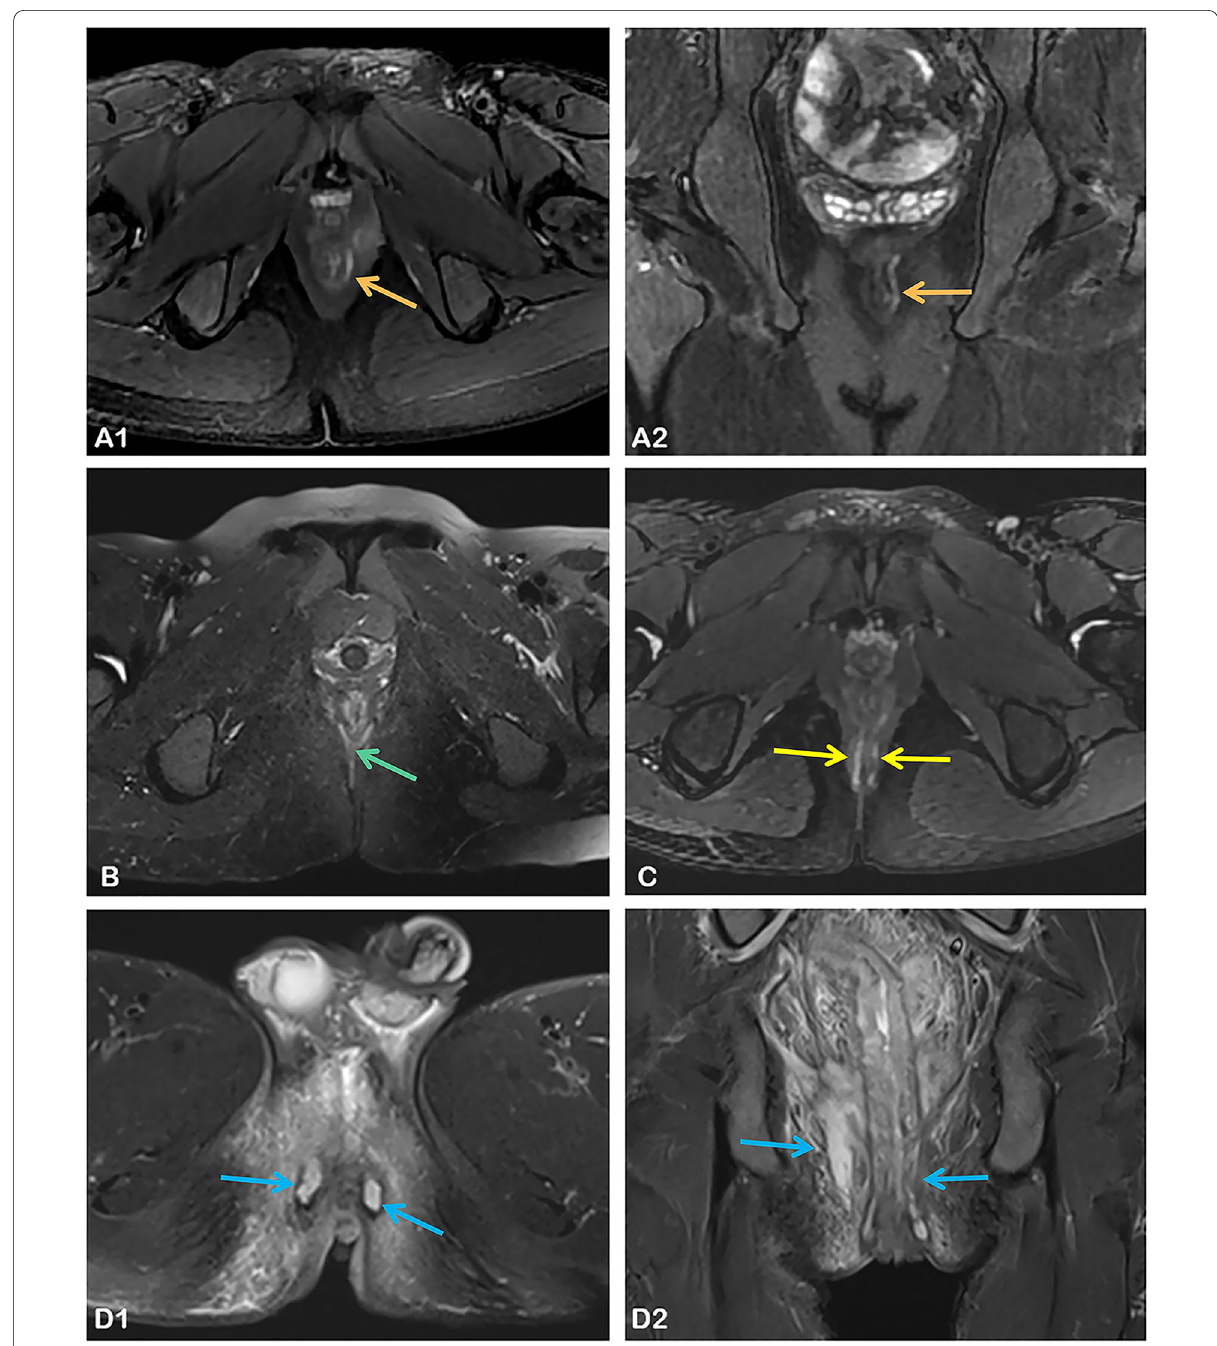
Fig. 2 Pelvic MRI images from four patients with Crohn’s disease. A1 , A2 Axial and coronal T2-weighted images of an 18-year-old male with linear high-signal fistula between the internal and external anal sphincters without branching or abscess formation (11 points, low activity group#); B Axial T2-weighted image of a 31-year-old female with a Y-shaped branching high-signal fistula (12 points, low activity group#); C Axial T2-weighted image of a 34-year-old male with multiple high-signal fistula (18 points, high activity group#); D1 , D2 Axial and coronal T2-weighted images of a 28-year-old male with multiple perianal abscesses and lesions involving the levator ani muscle (22 points, high activity group#). #Scores were calculated according to the Van Assche’s classification, with 14 or less in the low activity group and the rest in the high activity